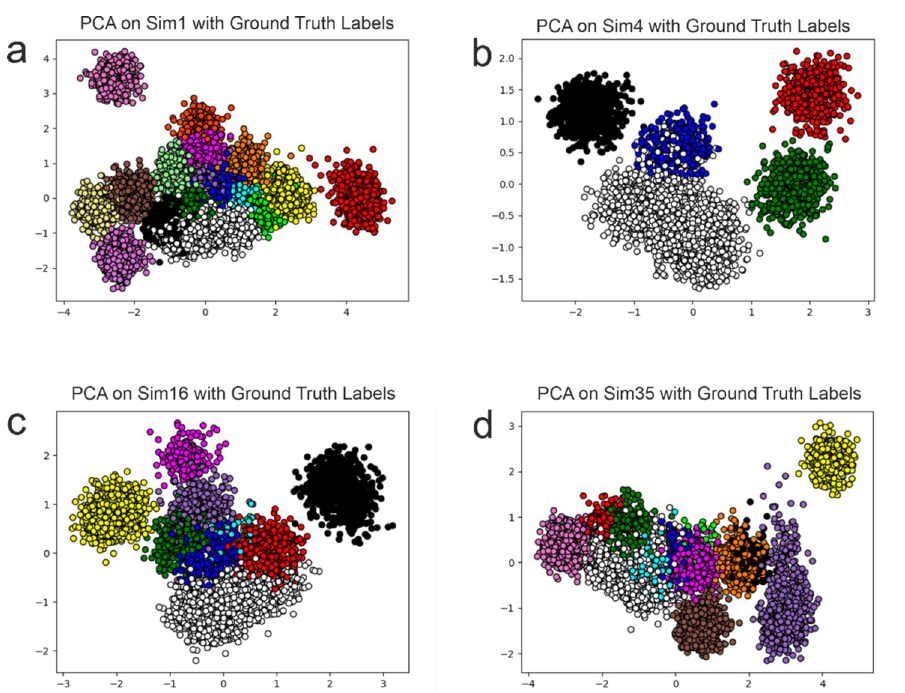
Fig 3. PCA projection of the synthetic datasets. PCA projection of 4 different simulations with distinct numbers of clusters; the colors represent the cluster assignment given in the ground truth.